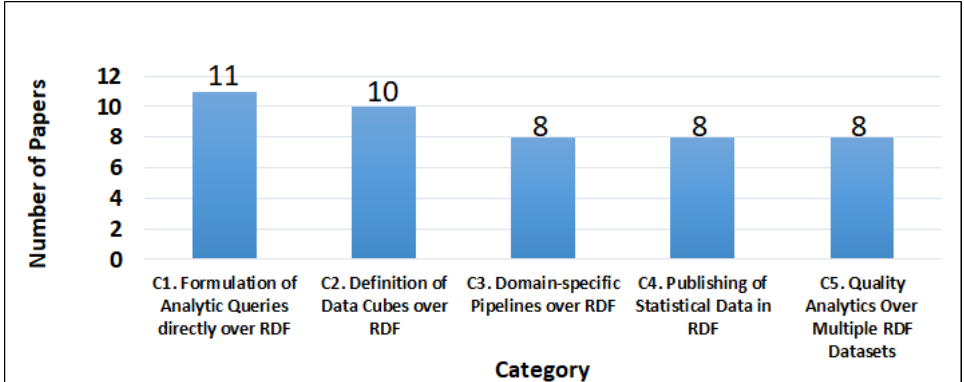
Figure 6. The number of surveyed works per